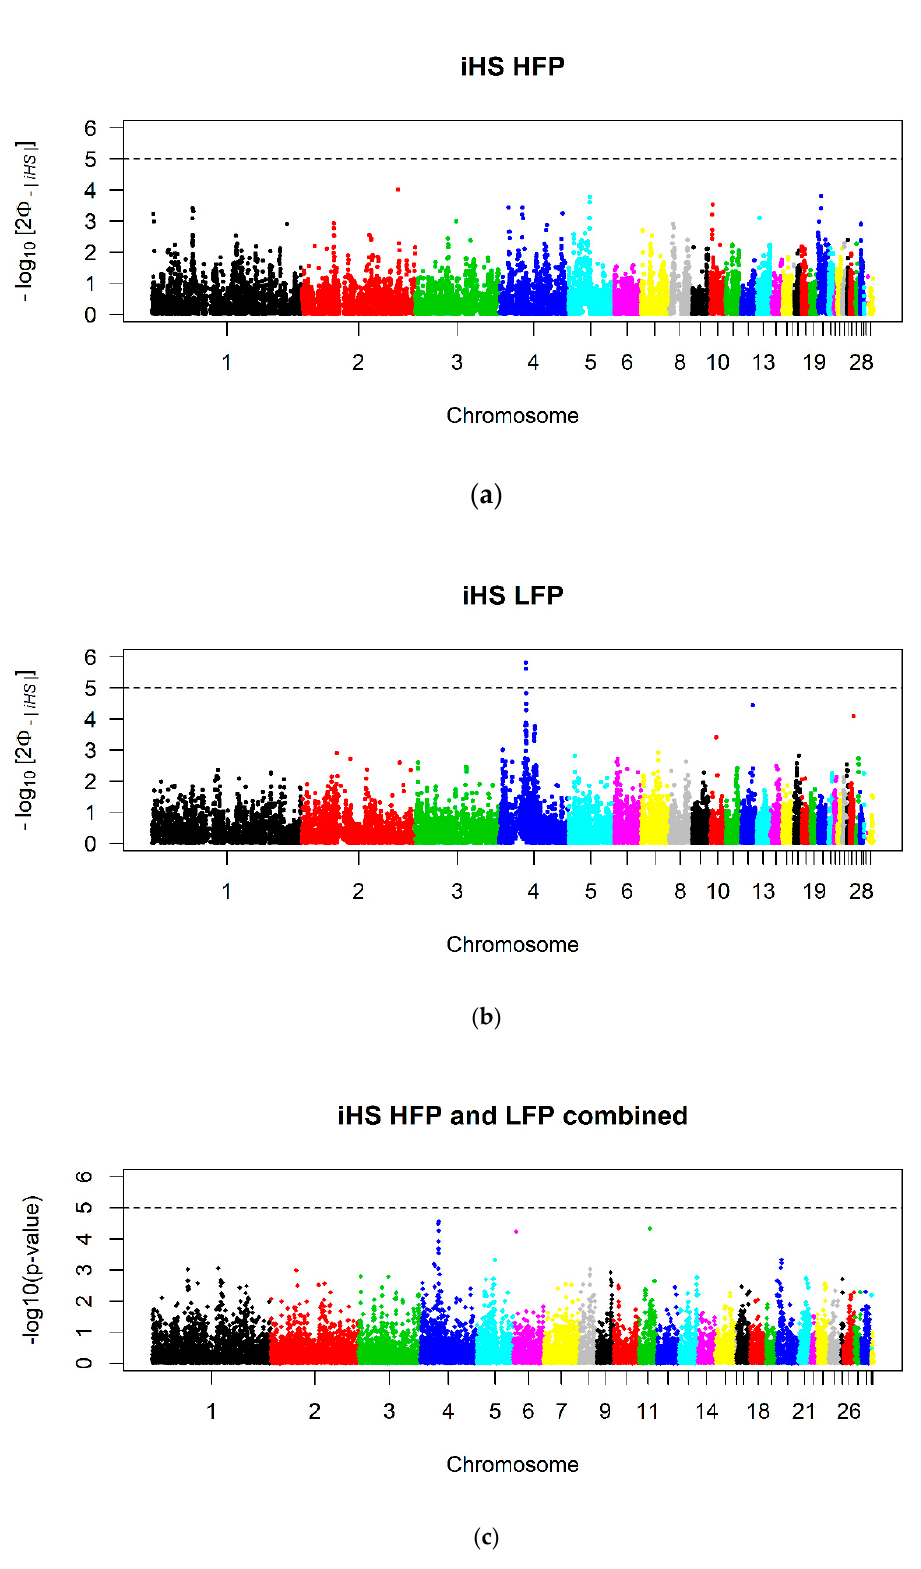
Figure 3. P -values of the integrated haplotype score (iHS) for ( a ) the high feather pecking line (HFP, n SNP = 22,425), ( b ) the low feather pecking line (LFP, n SNP = 23,084) and ( c ) their combination (n SNP = 16,766). The dashed lines indicate the nominal level of significance p ≤ 10 − 5 .